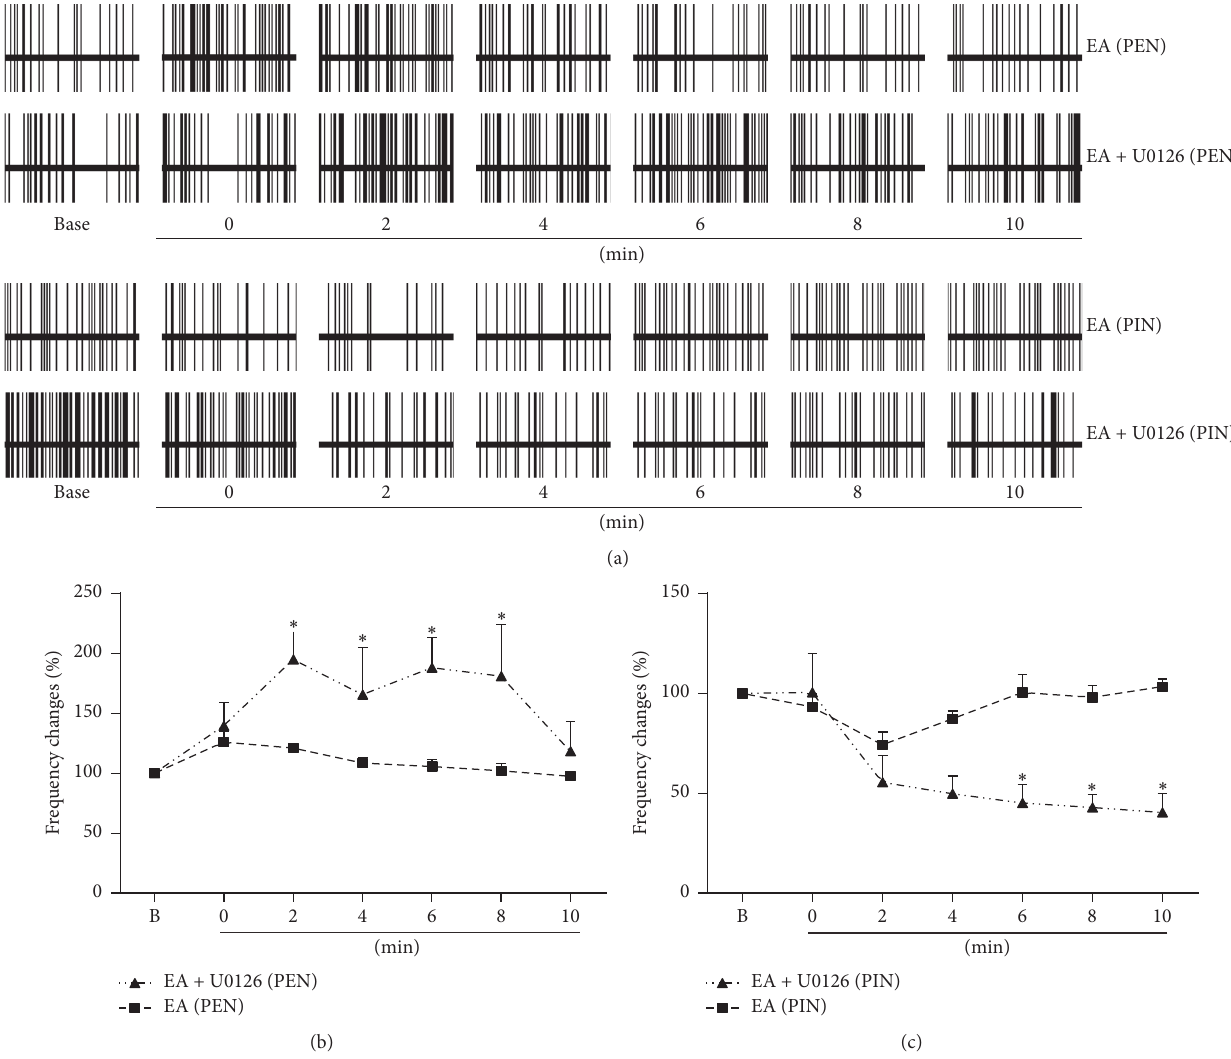
Figure 4: EA was ineffective in the presence of U0126. (a) Example of the effect of U0126 + EA and EA only on the impact of brief sciatic nerve stimulation on the firing rates of hippocampal PENs ( 𝑛 = 9 ) and PINs ( 𝑛 = 6 ). (b) Combination of U0126 and EA increased the discharge frequency changes of PENs caused by acute noxious stimulation to a larger extent than that observed in the EA group. (c) Combination of U0126 and EA decreased the discharge frequency changes of PINs caused by acute noxious stimulation to a larger extent than that observed in the EA group. ∗ : compared with EA group, 𝑃 < 0.05